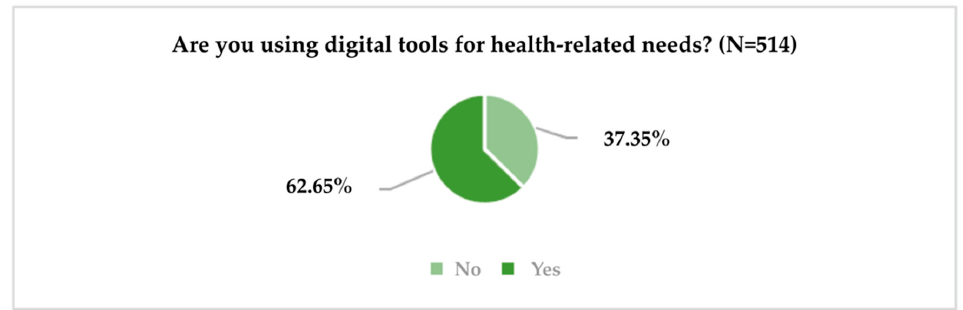
Figure 5. Use of digital tools for health